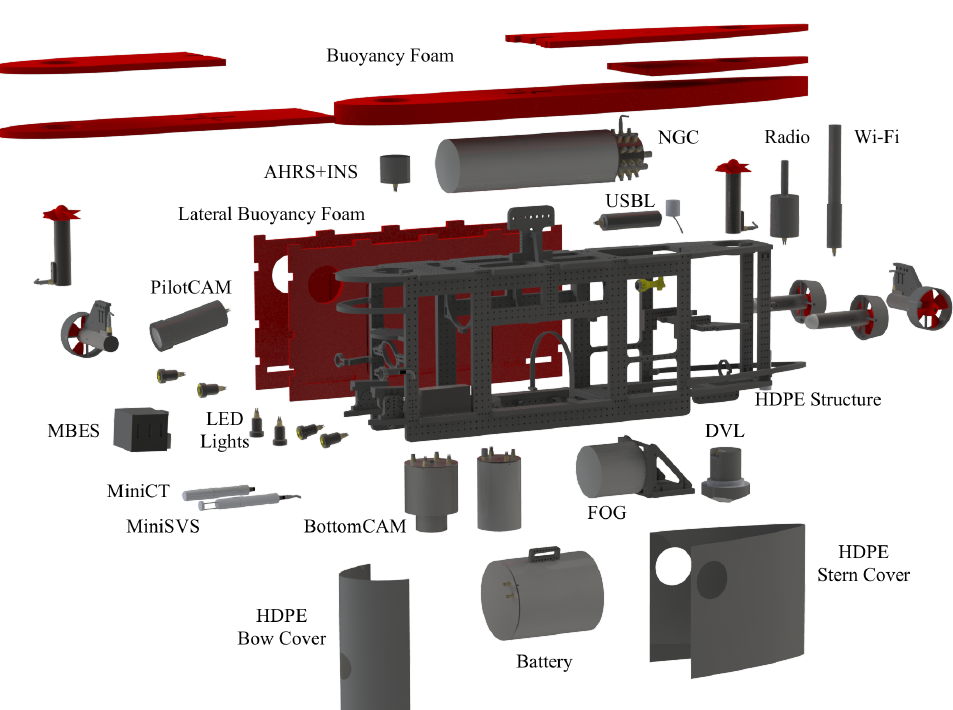
Figure 9. Exploded view technical drawing of Blucy UUV structure and hardware